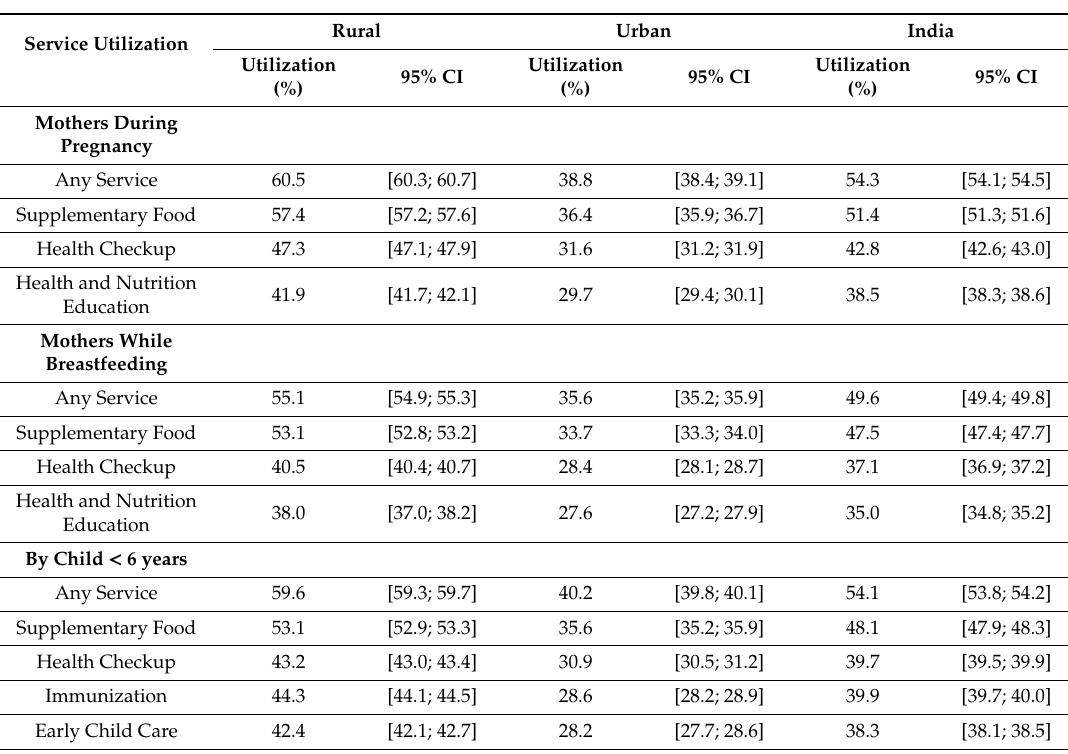
Figure 1. State- wise utilization of ICDS services (any) by mothers (during pregnancy and while breastfeeding) and children under six years, NFHS, 2016. Table 1. Utilization of ICDS services by mothers (during pregnancy and while breastfeeding) and children under six years, India, NFHS,